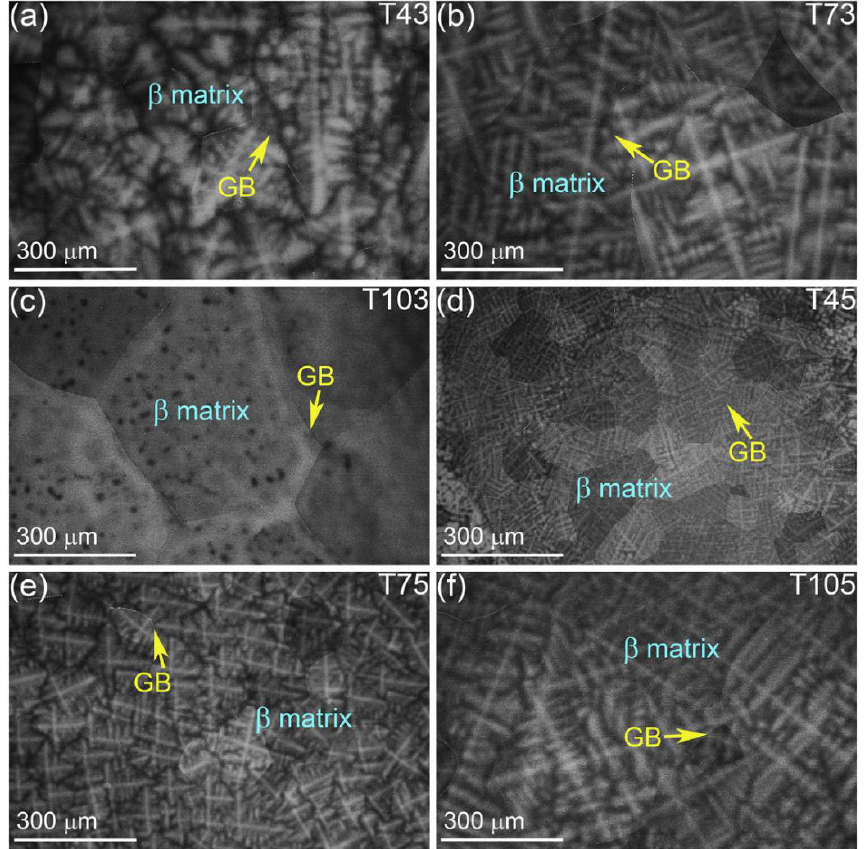
Figure 3. Backscattered SEM microstructural features of the Ti–26Nb–xZr–yMn (wt.%) alloys: ( a ) Ti–26Nb–4Zr–3Mn, ( b ) Ti–26Nb–7Zr–3Mn, ( c ) Ti–26Nb–10Zr–3Mn, ( d ) Ti–26Nb–4Zr–5Mn, ( e ) Ti–26Nb–7Zr–5Mn and ( f ) Ti–26Nb–10Zr–5Mn. Note that grain boundary is denoted as GB. (Reproduced with permission from ref. [104]. Copyright (2020),